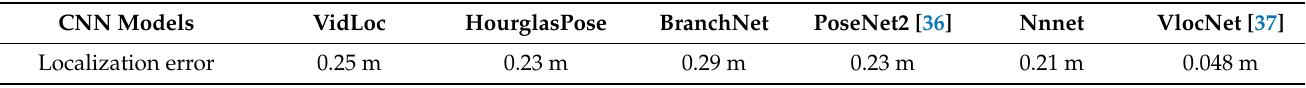
Table 2. Comparison of localization error with existing CNN models on the 7-Scenes dataset. CNN Models VidLoc HourglasPose BranchNet PoseNet2 [36] Nnnet VlocNet [37] Localization error 0.25